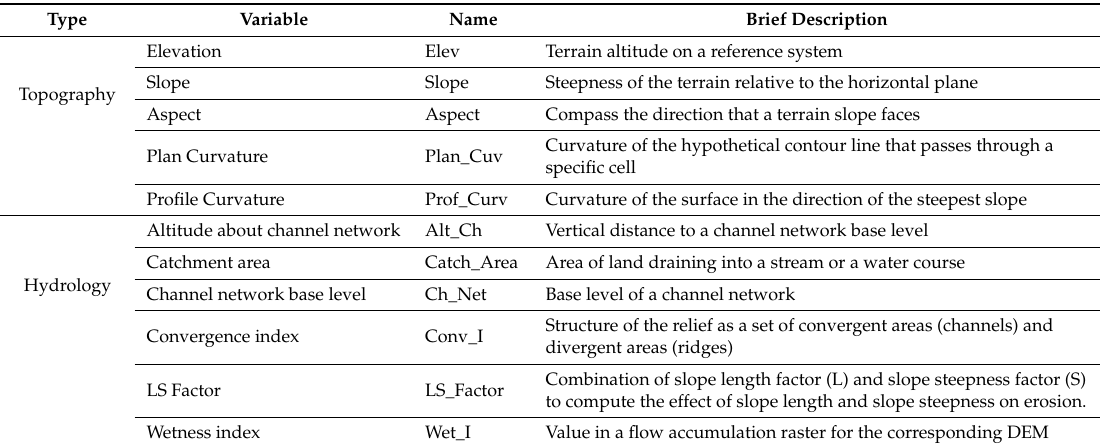
Table 3. DEM-derived variables from The Shuttle Radar Topographic Mission (SRTM) terrain